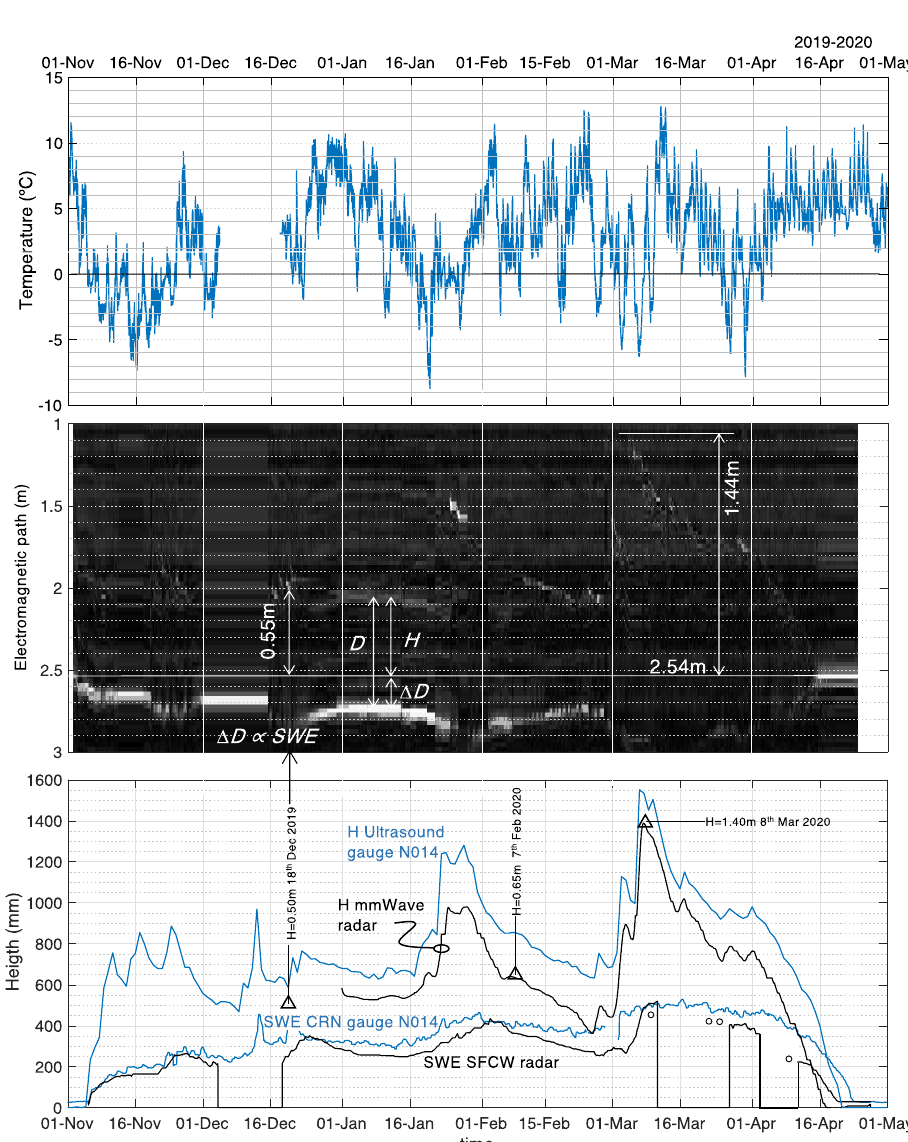
Figure 18. Evolution of certain magnitudes of interest from 1 November 2019 to 1 May 2020. In the figure above: Temperatures recorded in the position of the radar SFCW. Central figure: Graphic chart of the evolution of reflectance profiles over time. Figure below: Height comparison between the millimeter wave radar sensor and the CHE ultrasonic probe (N014) and snow water equivalent (SWE) measured by the SFCW radar and the CHE CRN N014.